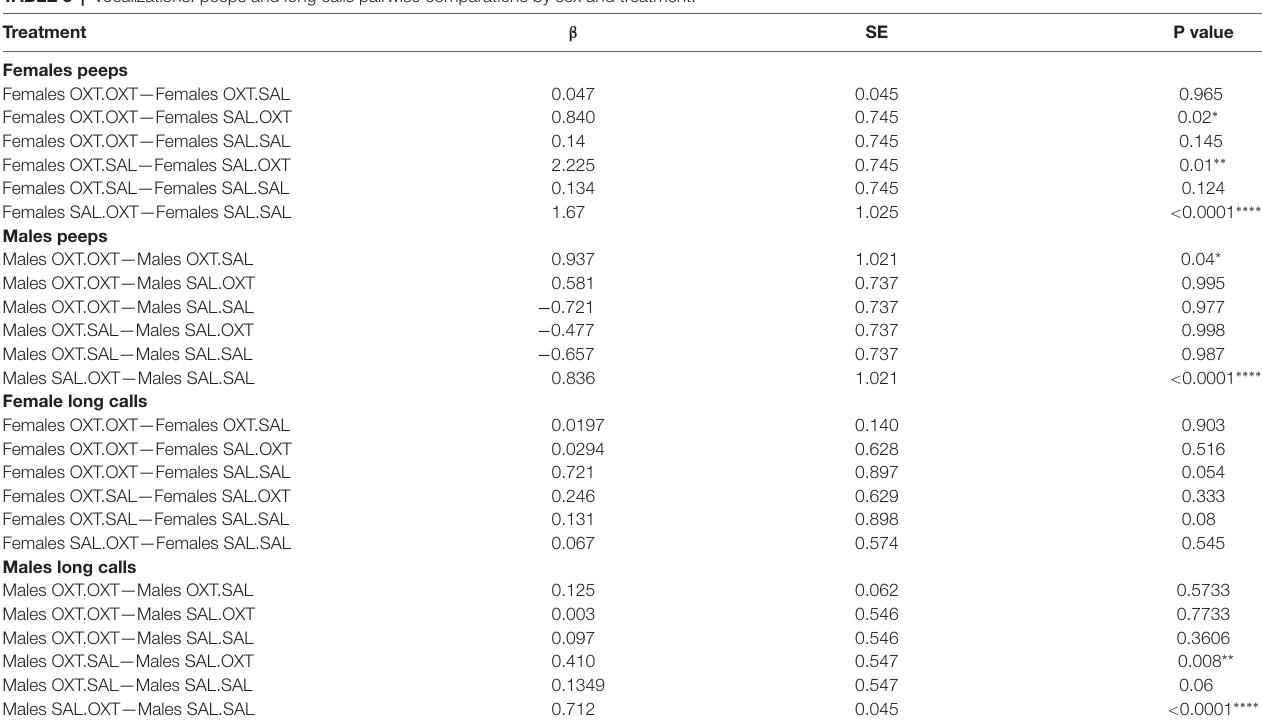
TABLE 3 | Vocalizations: peeps and long calls pairwise comparations by sex and treatment. Treatment β